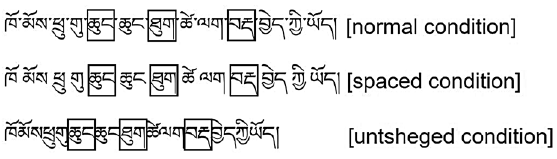
Figure 3. An illustration of local analysis based on areas of interest in different conditions (the boxes mean areas of interest). Translation: She greets children when she sees them.